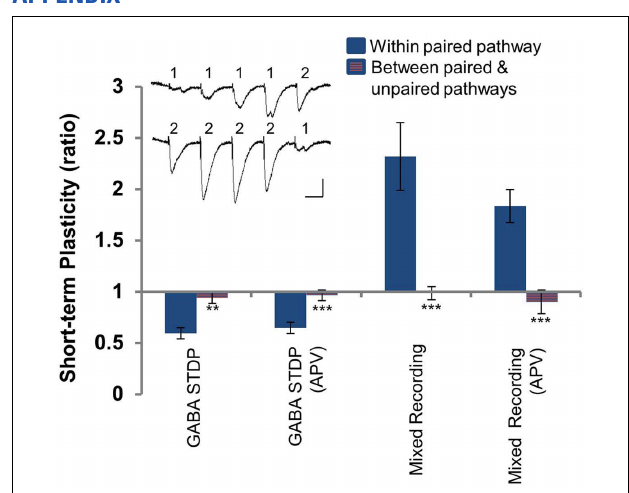
FIGUREA1 | Paired and unpaired pathways are independent. Short-term plasticity within the paired pathway (solid blue) and between the paired and unpaired pathways (blue and red hatched) for experimental conditions [GABA STDP, Figures 1 and 2 ; GABA STDP (APV), Figure 5C ; Mixed LTP, Figures 3 and 4 ; Mixed LTP (APV), Figure 6 ]. Inset: sample recording demonstrating the protocol used. Scale bars: 50pA,